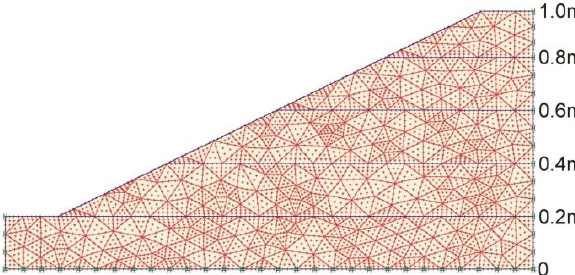
Figure 8: Geometric model of the slope (type 1 model) of a flood embankment designed in the Plaxis